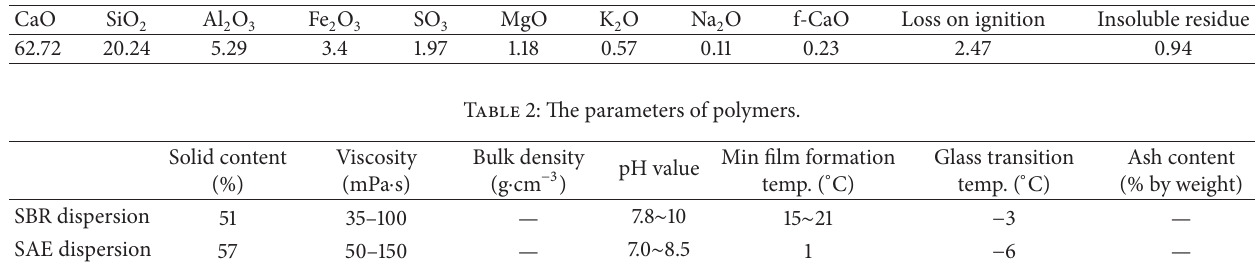
Table 1: Chemical composition of P ⋅ II 52.5R Portland cement (% by weight).